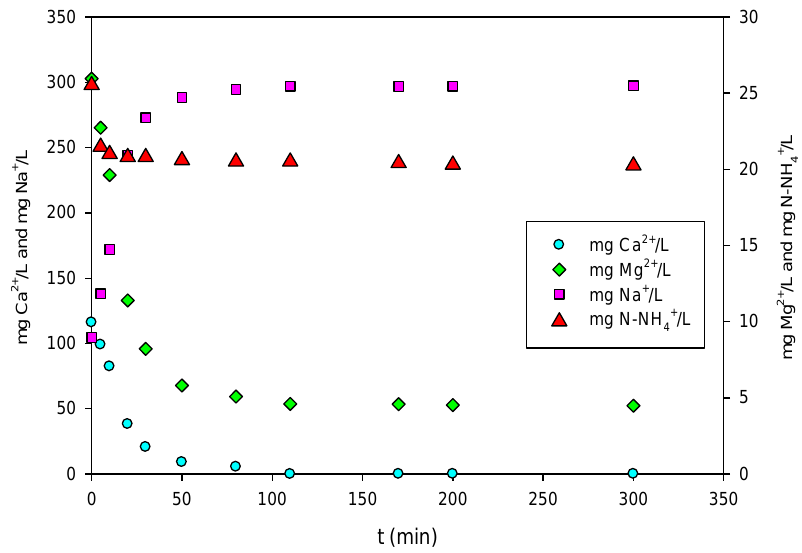
Figure 3. Evolution of the concentration of the main cations during the development of kinetics with Purolite SSTC60.